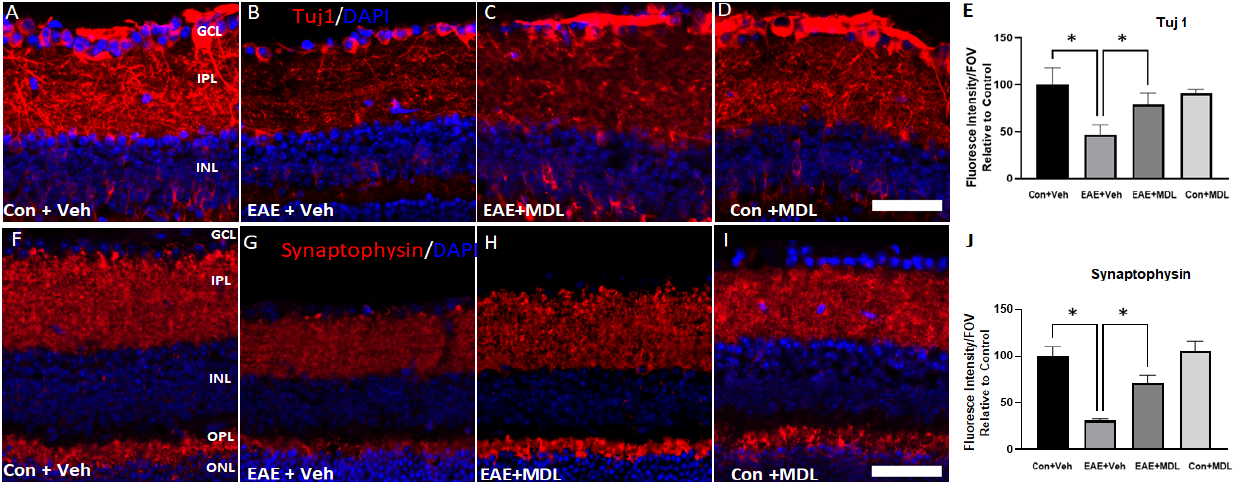
Figure 4. EAE-induced neurodegeneration in the inner retina is reduced by MDL 72527 treatment. Representative confocal images of retinal cryostat sections showing the immunofluorescence staining of Tuj1 ( A – D ), a marker for RGCs and their axons, and synaptophysin ( F – I ), a pre-synaptic marker. Histograms showing the ImageJ quantification of Tuj 1( E ) and Synaptophysin ( J ) levels studied by changes in fluorescence intensity. EAE-induced downregulation of both protein markers was improved in response to SMOX inhibition by MDL 72527 treatment. Scale bar: 50 μ m. Data are presented as mean ± SD. * ( p < 0.01); # ( p < 0.05). GCL, ganglion cell layer; INL, inner nuclear layer; IPL, inner plexiform layer; ONL, outer nuclear layer; OPL, outer plexiform layer. n = 4–6 per group and representative images are presented.